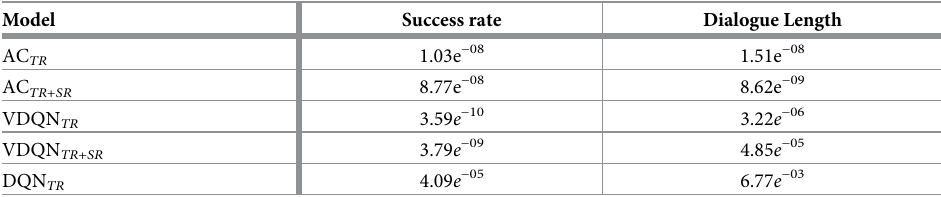
Table 8. Statistical significance test result: p value at 5% significance level.